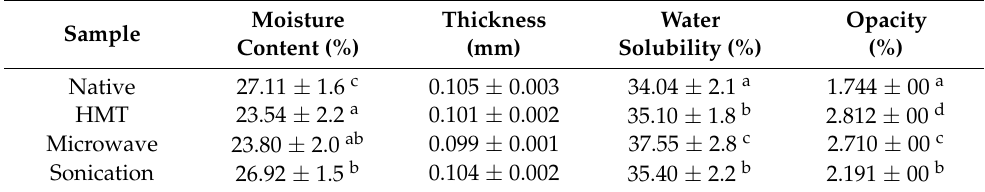
Table 6. Moisture content, thickness, water solubility, and opacity of native and modified starch films. Sample